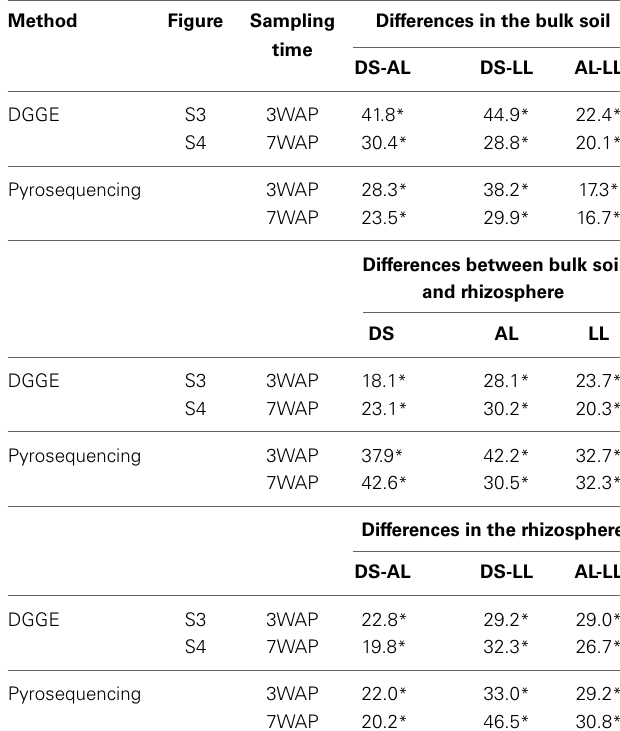
Sampling Differences in the bulk